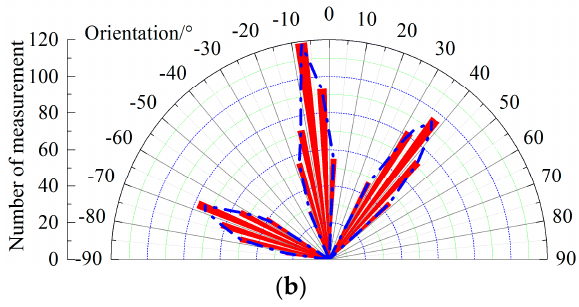
Figure 12. Statistical results of natural fracture (NF) ( a ) length and ( b ) dip angle.